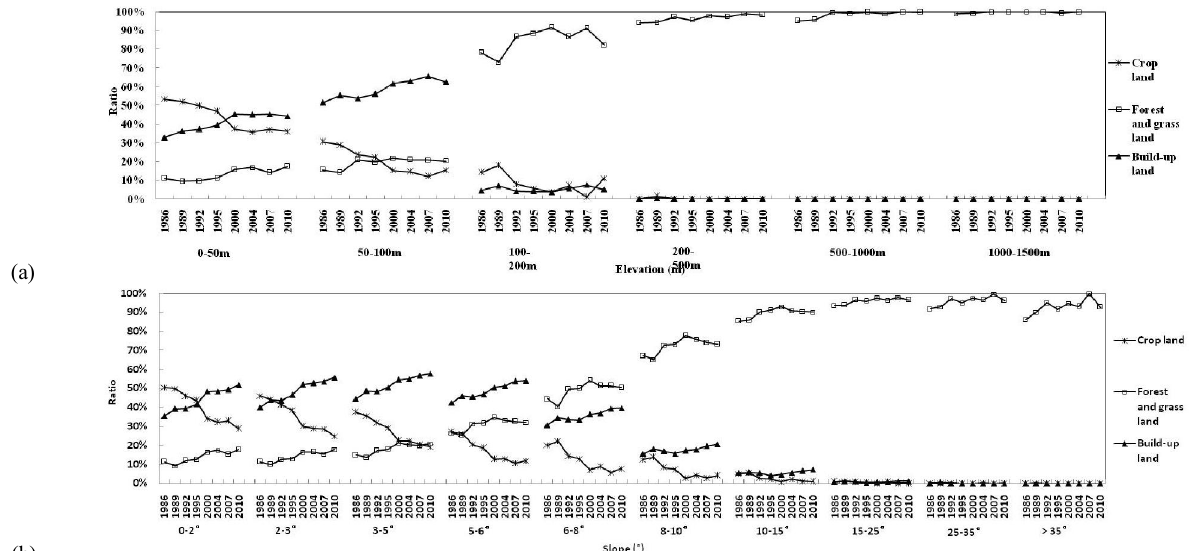
(b) Figure.5 Temporal variation of different land cover percentage by Landsat TM over various elevation (a) and slope (b) range